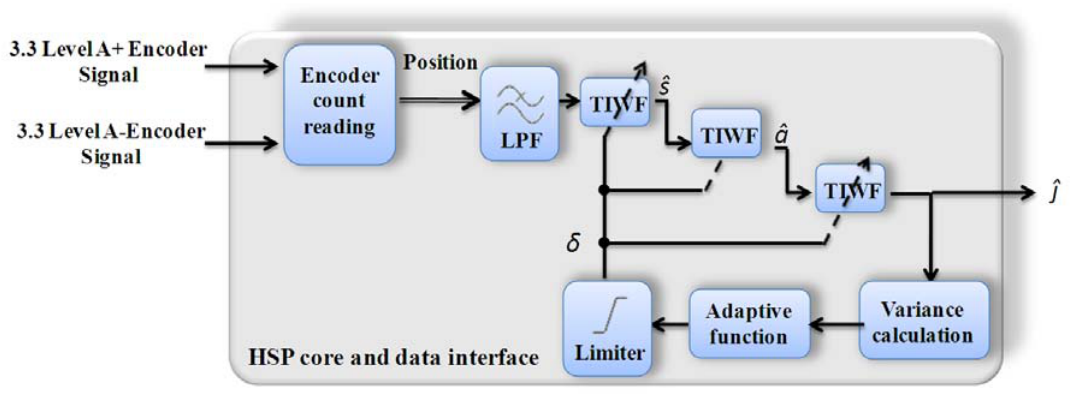
Figure 6. Block diagram for jerk monitoring utilizing the HSP core.